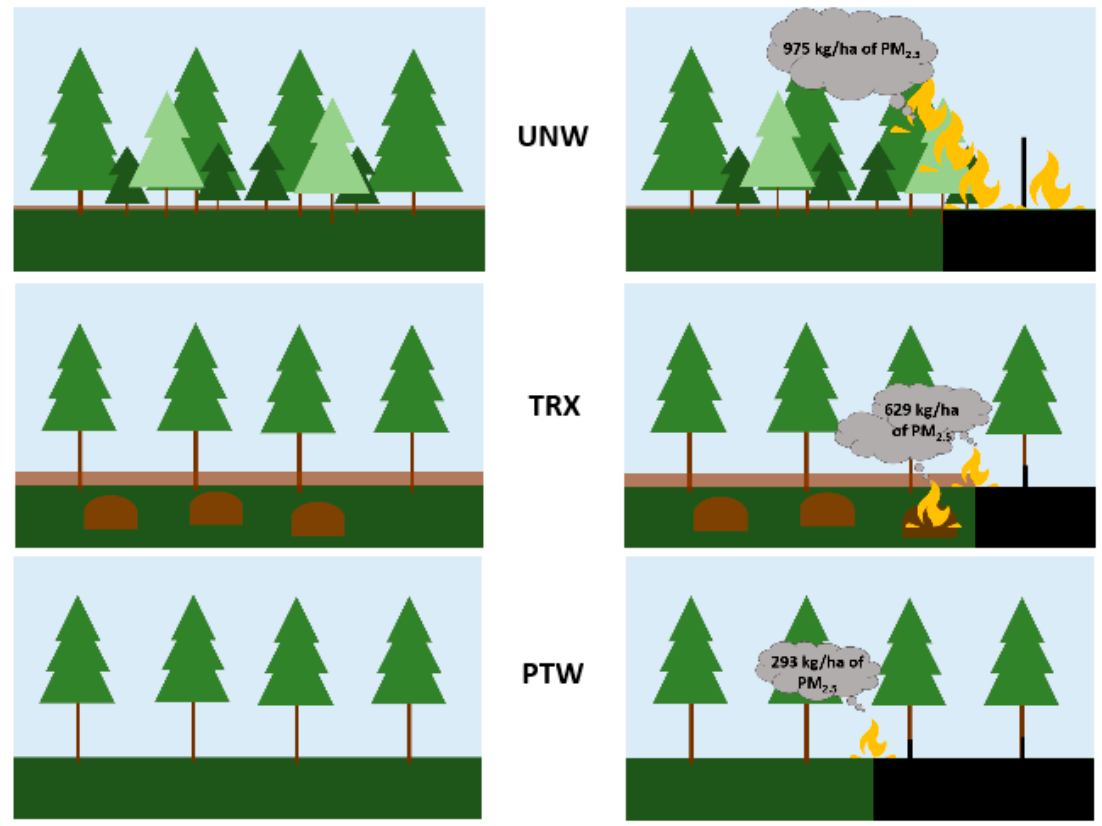
Figure 6. Simplified representation of fuel distribution before and after thinning, displayed with example PM 2.5 emission values from our comparison. Scenarios illustrated are the following: UNW—untreated fuels burned in wildfire, TRX—prescribed fire in activity fuels left from thinning, and PTW—a wildfire ignited on the post-treatment landscape.